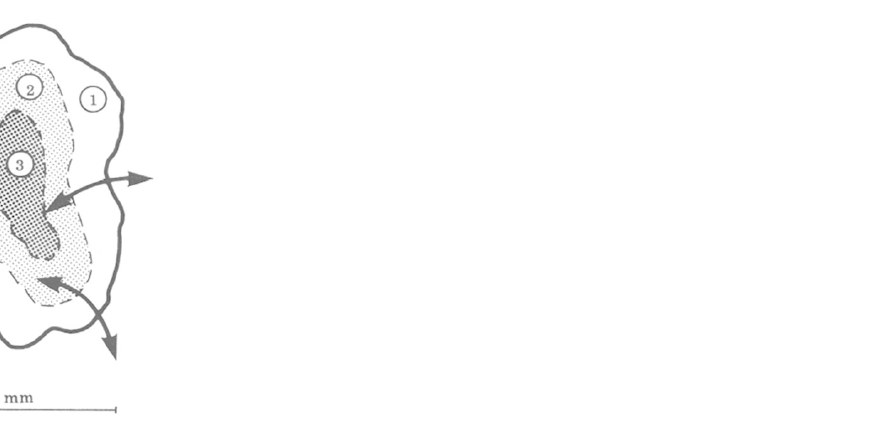
7 of 28 Figure 3. Glauconitization of substrates differing by size at the seawater (or interstitial water)–fecal pellet interface. ( a ) Small grains; ( b ) coarse grains; ( c ) lithoclasts; ( d ) hard ground. Small dots indi- cate the density of the glauconitization process and arrows represent cation exchange, after Odin and Matter [3]. This geometric scale of cation exchanges was the subject of a scheme applied to a fecal pellet measuring one mm in diameter [23]. Subsequently, we can distinguish (1) an external and porous transit sector, where the inherited mineral phases dominate the newly formed phases and where the first precipitations of iron oxyhydroxides are rap- idly defined; (2) a deeper middle sector, where both the departures and arrivals of the cations are efficient, which is the privileged site of the neoformations of glauconitization; and (3) a more internal sector, which remains free of glauconitization (Figure 4). In the